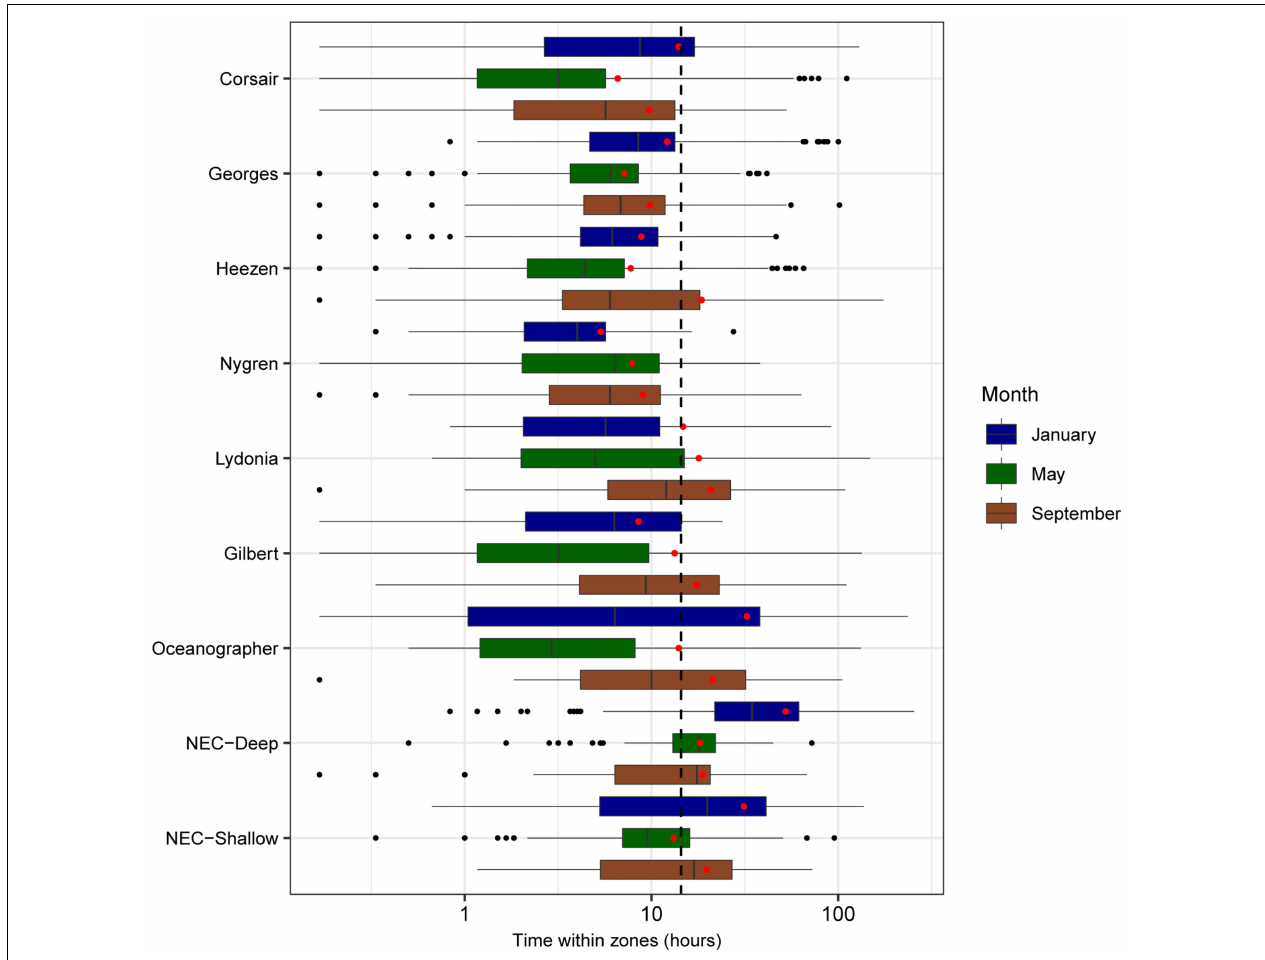
FIGURE 9 | Boxplots of residence time (h) for all tracks overlapping zones of interest segregated by month (sample sizes for the zone-month combinations are given in Table 4 ). Mean residence times for each month-zone combination are shown (red diamonds), as well as overall average (black dashed